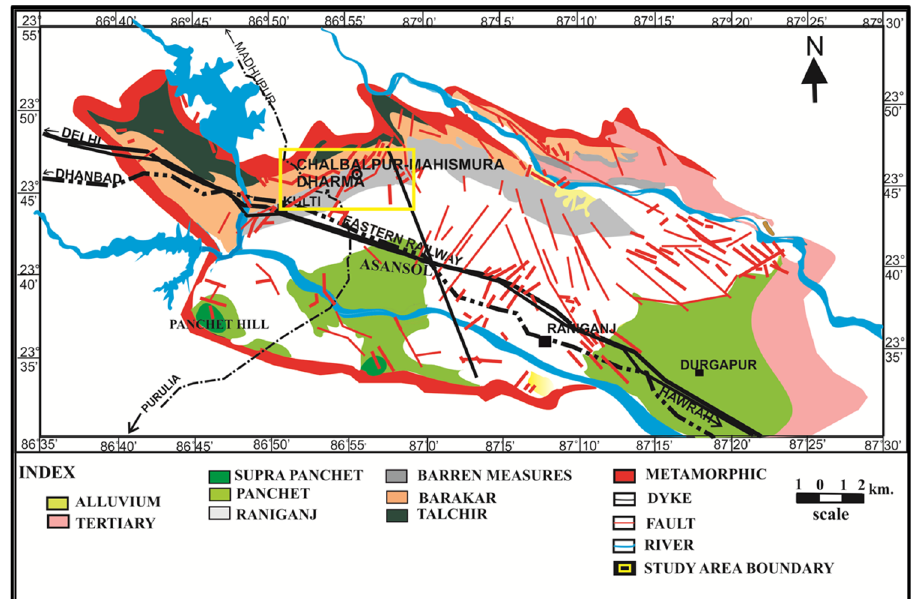
Fig. 1 Geological map of Rani- ganj Coal